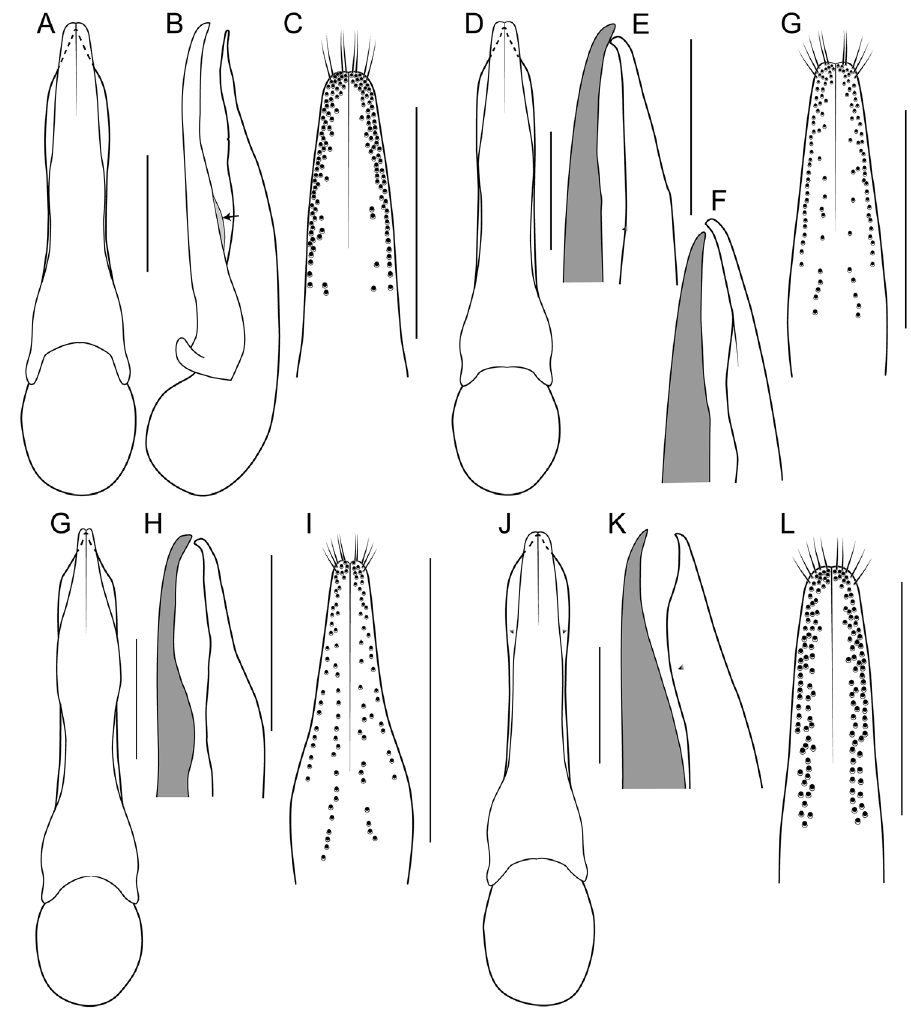
Figure 15. Bolitogyrus concavus Brunke ( A–C ), B. rufomaculatus (Shibata) ( D, E, G ), B. depressus Cai et al. ( F ), B. taiwanensis (Hayashi) ( G–I ) and B. tumidus Brunke ( J–L ). Aedeagus in parameral view ( A, D, G, J ), aedeagus in lateral view showing expansion of the paramere (arrow) ( B ), apex of aedeagus in lateral view ( E, F, H, K ), peg setae of paramere ( C, G, I, L ). Scale bar: 0.5